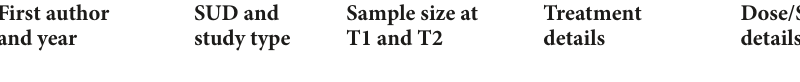
TABLE 1 Main summary of study